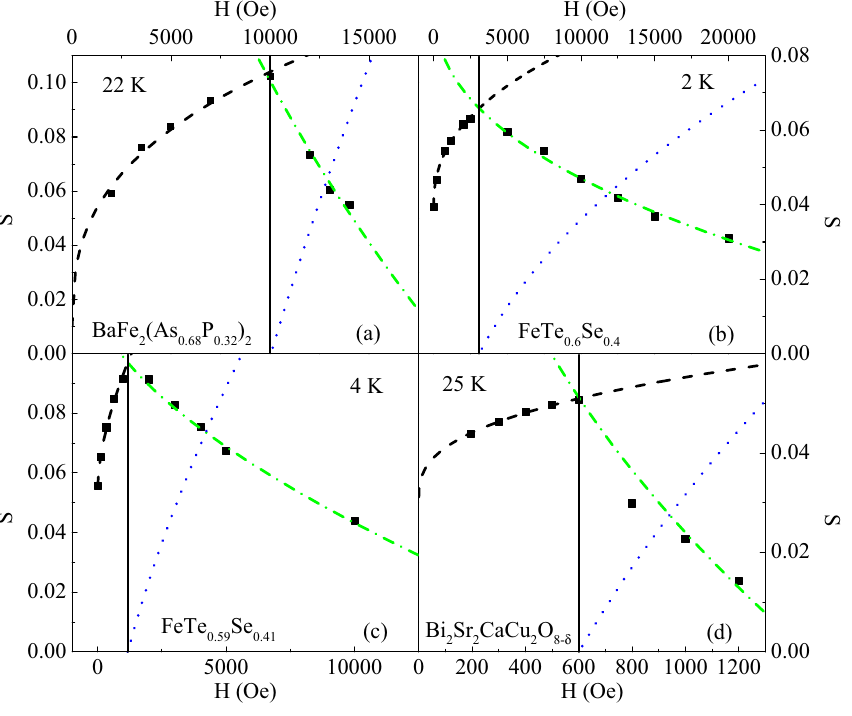
Figure 4. Fit procedure of Fig. 3 applied to the S as a function of H curves of different samples. Data have been taken from literature, in particular from 56 (for the panel (a)), 20 (for the panel (b)), 19 (for the panel (c)), and 25 (for the panel